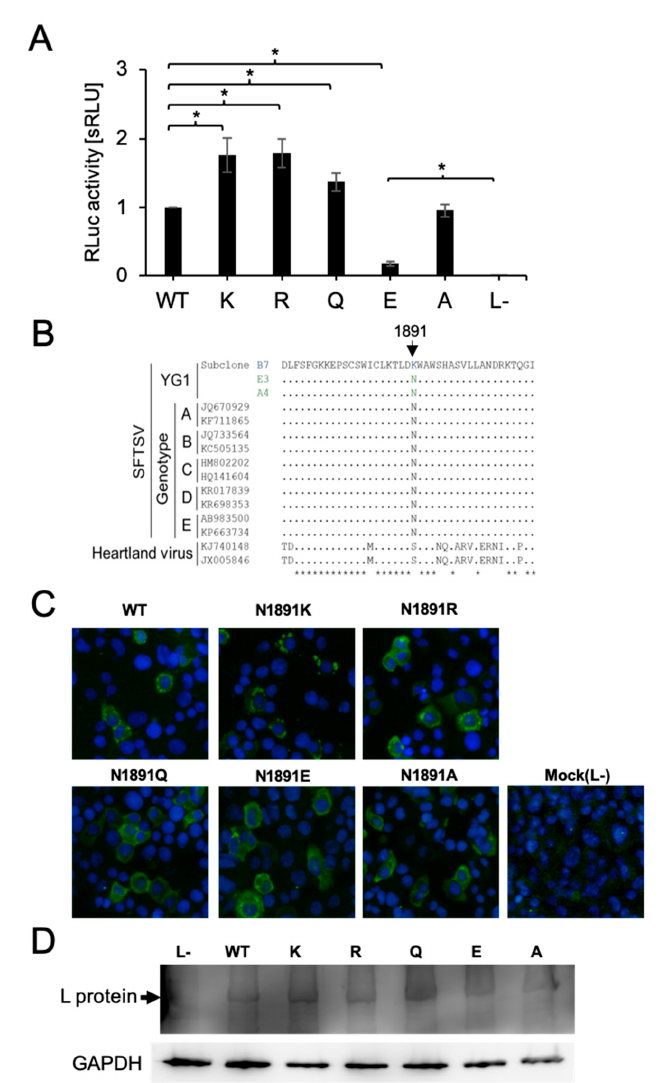
Figure 2. Minigenome assay for SFTSV L protein variants. ( A ) The polymerase activity of each L protein variant was measured thorough an RLuc minigenome assay in the BHK/T7-9 cells. The activities of RLuc were standardized to the FLuc activity (transfection control). Results are shown in the bar graph (the mean of the standardized relative light units [sRLU] as a fold-change value compared to WT with standard deviation in five independent transfection assays) with error bars representing the standard deviations of the means and the asterisks indicating a significant difference from 1891N (WT) or L- (negative control) by a two-tailed one sample t -test, as follows: * p < 0.01. ( B ) Amino acid sequences of SFTSV and Heartland viruses of the L protein from position 1870 to 1910 are aligned to subclone B7. Amino acids matched to subclone B7 are shown as dots. Position 1891 is indicated by the black arrow. ( C ) Indirect immunofluorescence assay for L protein variants expressed in BHK/T7-9 cells ( × 100). BHK/T7-9 cells were transfected with L protein variant plasmids, fixed with acetone, and stained with anti-L peptide rabbit polyclonal antibody and Alexa- 488 labeled anti-rabbit IgG goat monoclonal antibody as the secondary antibody for the SFTSV L protein with DAPI for the nuclei. The merged pictures of each SFTSV L protein variant and nucleus are shown in green and cyan, respectively. ( D ) Western blotting assay for L protein variants expressed in HEK 293T cells. HEK 293T cells were transfected with L protein variant plasmids. Cell lysates were used for SDS-PAGE following a Western blotting assay with the anti-L peptide rabbit polyclonal antibody. For standardization, GAPDH was detected by the peroxidase conjugated anti-GAPDH monoclonal antibody. Black arrows indicate the bonds for the L